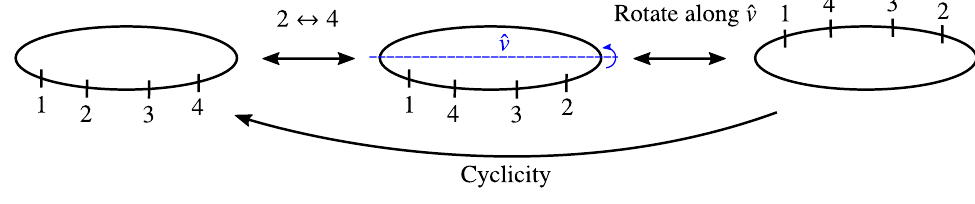
Figure 2 . Exchanging the points 2 and 4 is a symmetry of the